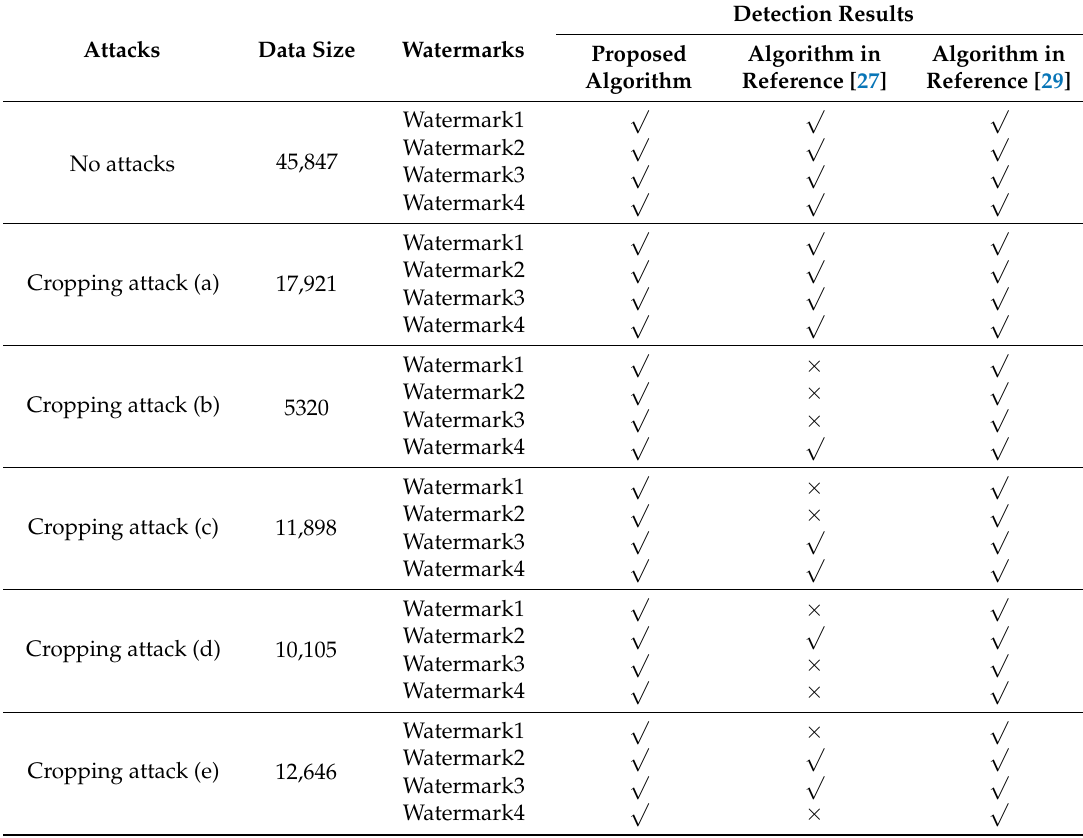
Table 5. Robustness against cropping attacks for different